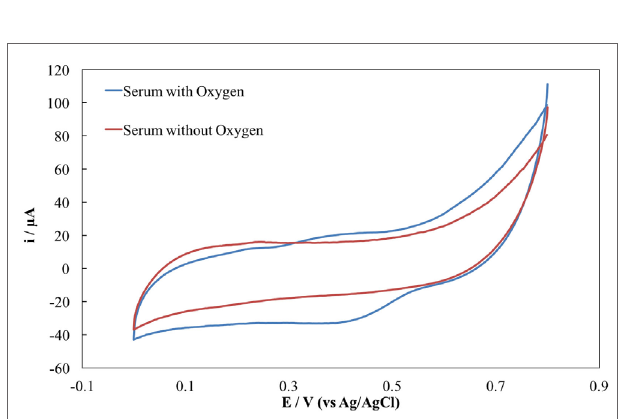
FigUre 3 | cVs of laccase cathode in human serum in the presence (blue) and absence (red) of oxygen .